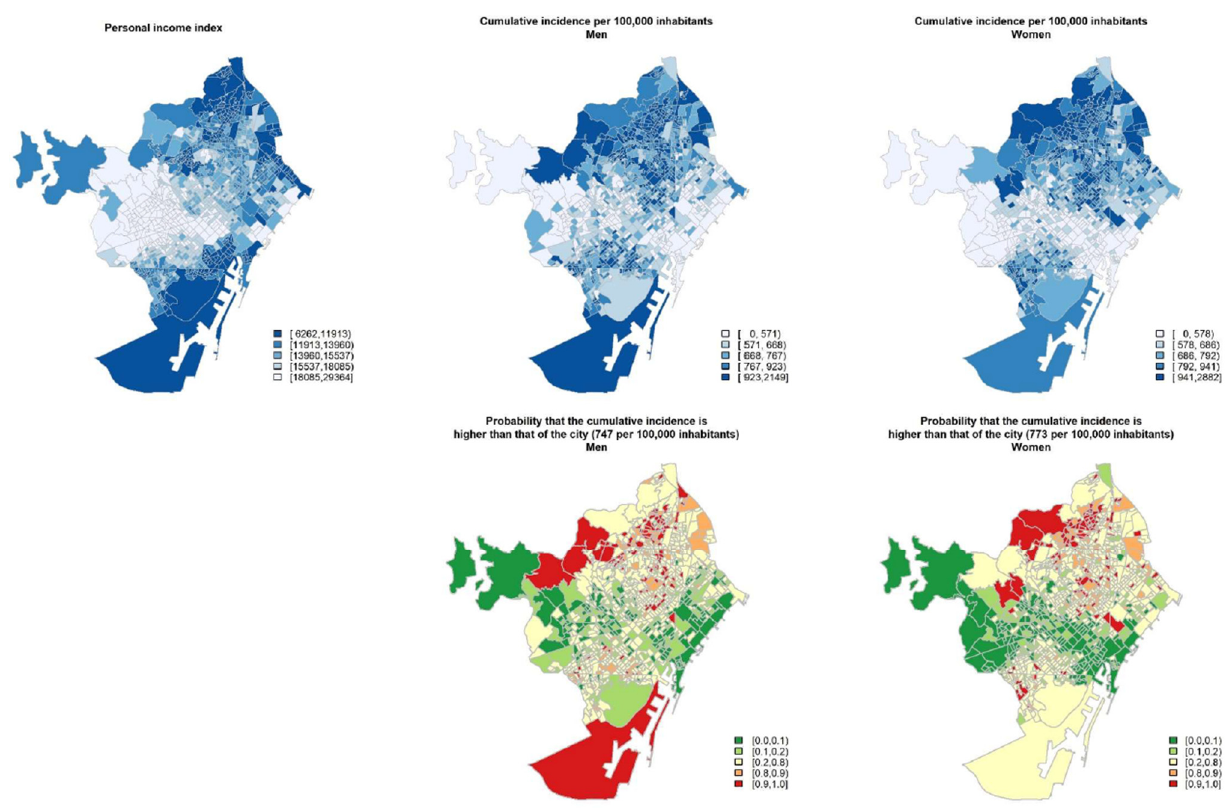
Figure 2. Geographical distribution (at census tract level) of 2016 personal income index, cumulative incidence of COVID-19 per 100,000 inhabitants according to sex and probability of the cumulative incidence being higher than that of the city. Period from 1 March to 15 July 2020 in Barcelona city.